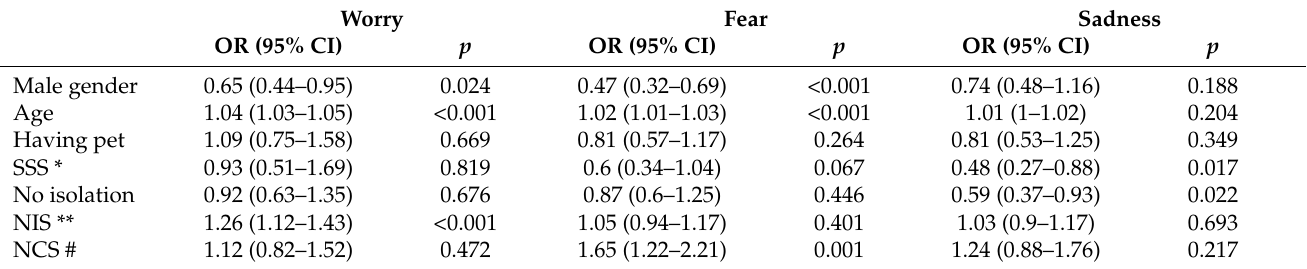
Table 5. Association between patient characteristics, support and source of information and the presence of negative feelings during SARS-CoV-2 acute infection in the first wave.